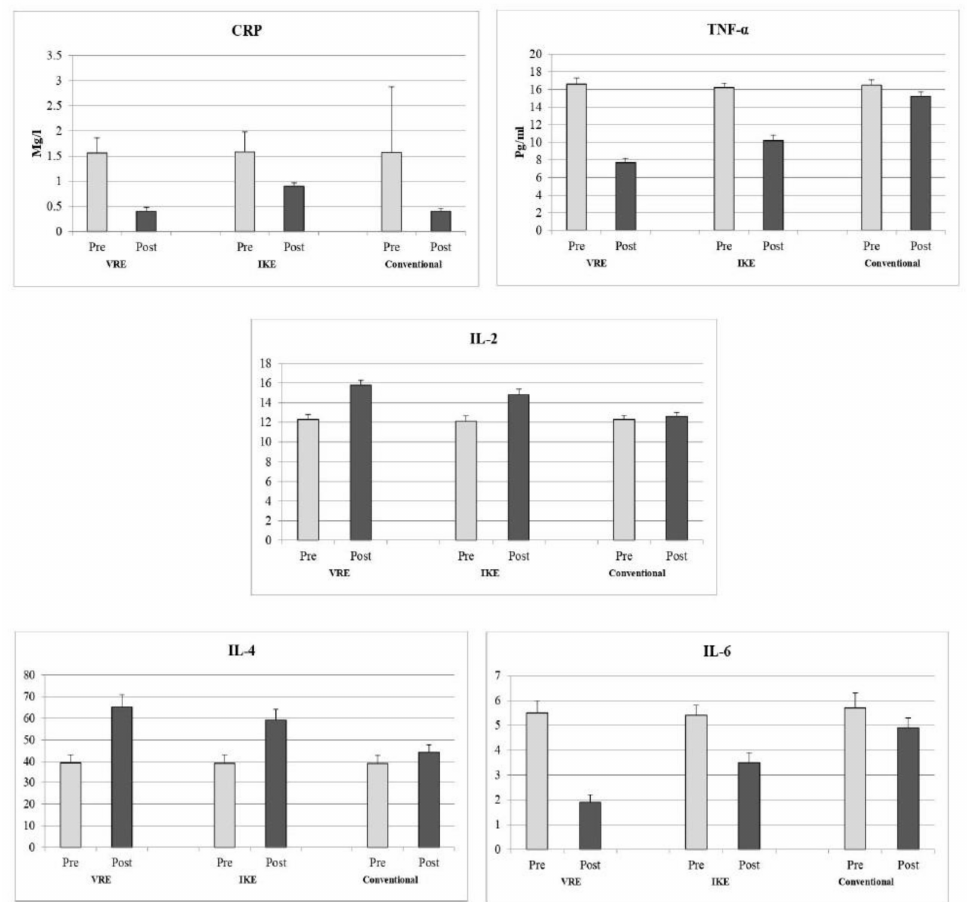
Figure 3. Pre and post analysis of inflammatory biomarkers of VRE, IKE, and conventional groups. CRP—C-reactive protein, TNF- α —tumor necrosing factor, IL—interleukin, VRE—virtual reality exercise, IKE—isokinetic